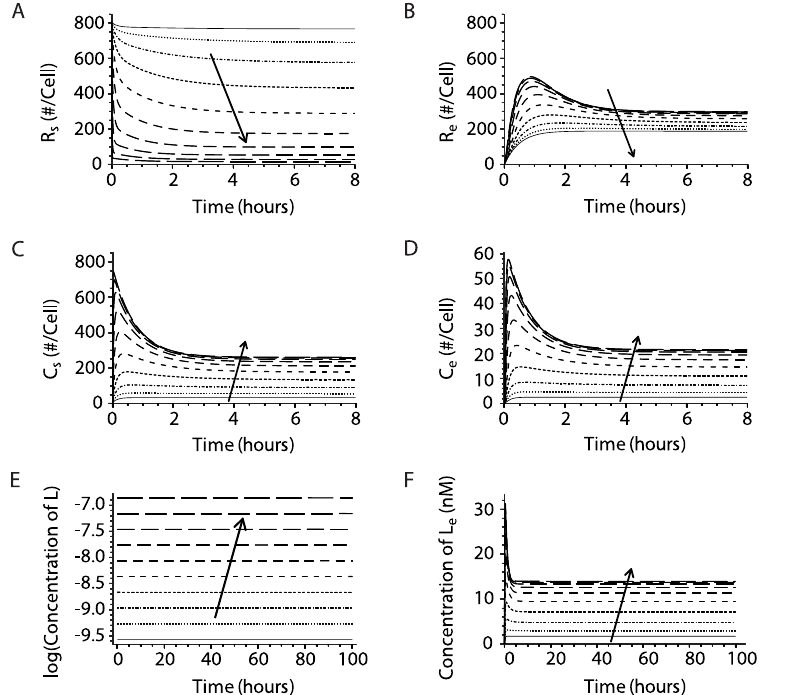
Figure 2. IL-15 concentration quantitatively influences the receptors, complexes and ligands on the surface and in endosomes of quiescent NK cells. Simulations of intermediate affinity receptor binding on NK cells were performed using estimates of kinetic parameters derived from published studies. Solutions of differential equations were depicted in two columns, showing receptor, IL-15/IL-15R complex numbers, and ligand concentration at the cell surface ( A , C , E ), and in endosomes ( B , D , F ). The model solutions were obtained from simulations where IL-15 concentration serially doubled from 3.9 ng/ml to 2000 ng/ml, depicted by different lines. The arrow represents increasing IL-15 concentrations.